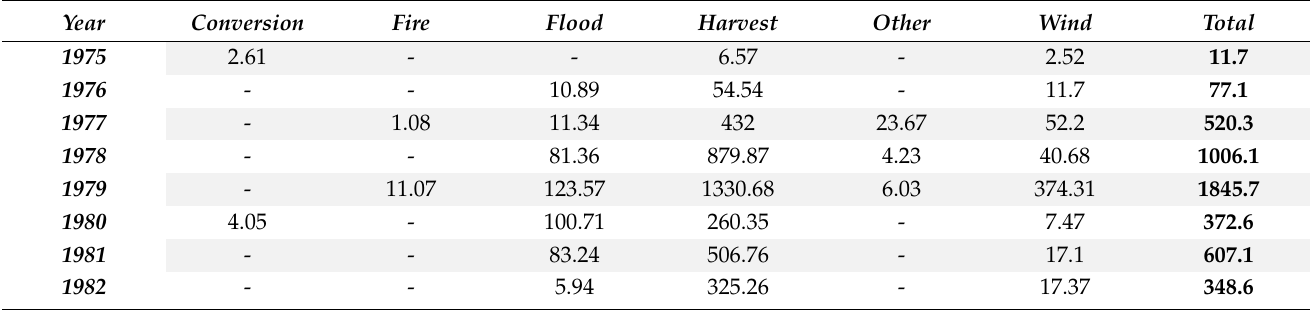
Figure 1. Cass and Lake County Minnesota study sites (yellow) with statewide forest canopy (green) and disturbed areas (black). Coordinate system: North American Datum of 1983, Universal Transverse Mercator Zone 15 North. For reference, 1 degree is equivalent to approximately 110 km in the north to south direction, or 78 km in the east to west direction. Table 1. Area disturbed (hectares) within the study area (Figure 1) displayed by year of disturbance (1975–2017) and disturbance agent. This table includes areas corresponding to overlapping disturbances where more than one change event has occurred.